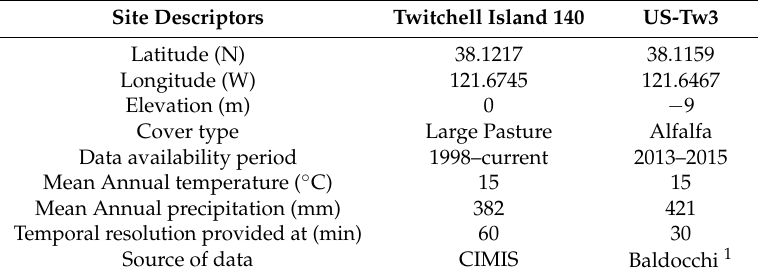
Table 1. Description of sites used in this study.